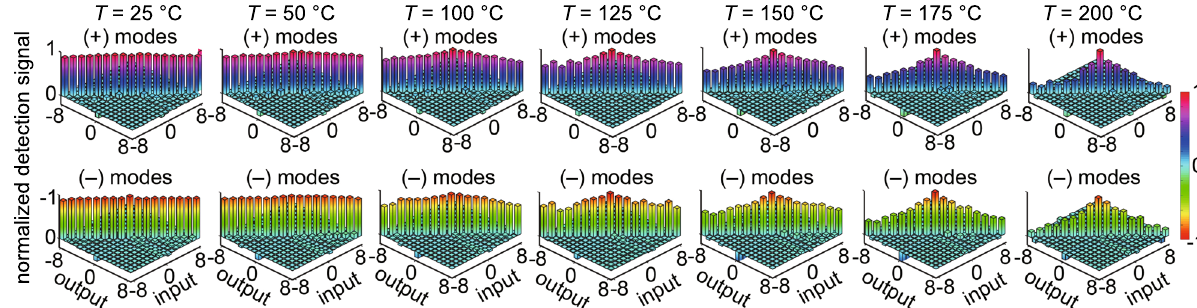
Fig. 5 Measured signal matrices. The average values of the directly measured signal of each input mode through each decoding (output) channel at various turbulence strengths. The color indicates the normalized signal value between − 1 and 1. The top and bottom rows are for ( + ) and ( − ) input modes as described in Eq. (1),